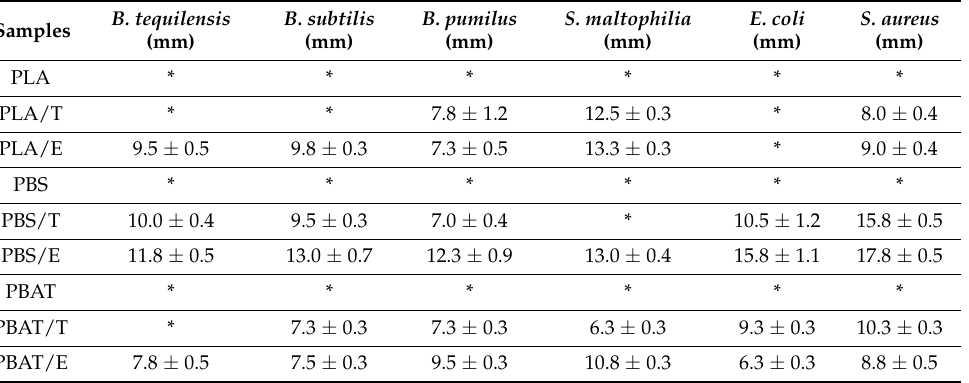
Table 1. Antimicrobial activity determined by disk diffusion method (sample 5 mm in